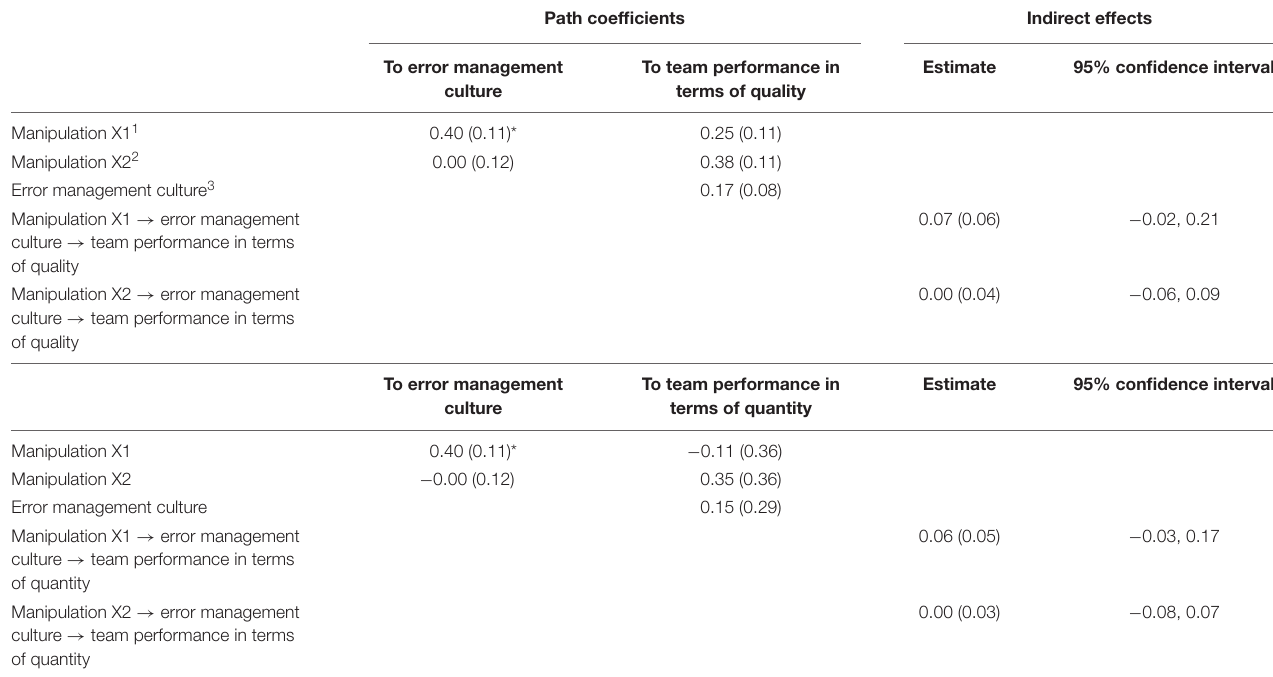
TABLE 7 | Mediation analysis in Study 2.